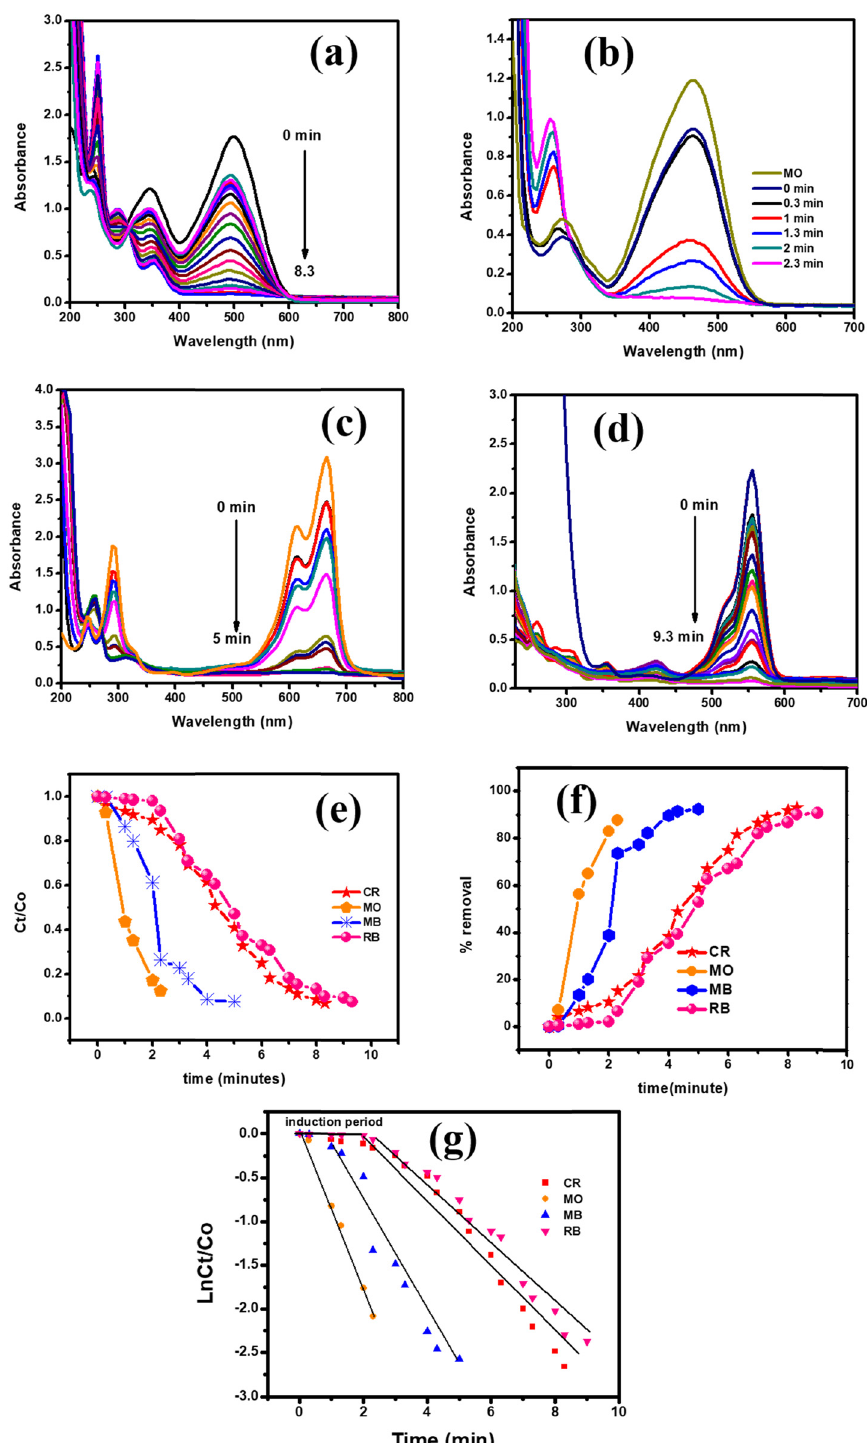
Figure 4: Time - dependent UV - Vis spectrum for the degradation of CR ( a ) , MO ( b ) , MB ( c ) , and RB ( d ) , the concentration of all the dyes are 0.05 mM and 0.5 mL of 1 M NaBH 4 and 10 mg of the CuNi@CP catalyst was used in this experiment. The kinetic data C t / C 0 ( e ) and % removal ( f ) showing the strongest activity of MO dye, the k app and R 2 value determined from the trendline of ln C t / C 0 ( g )